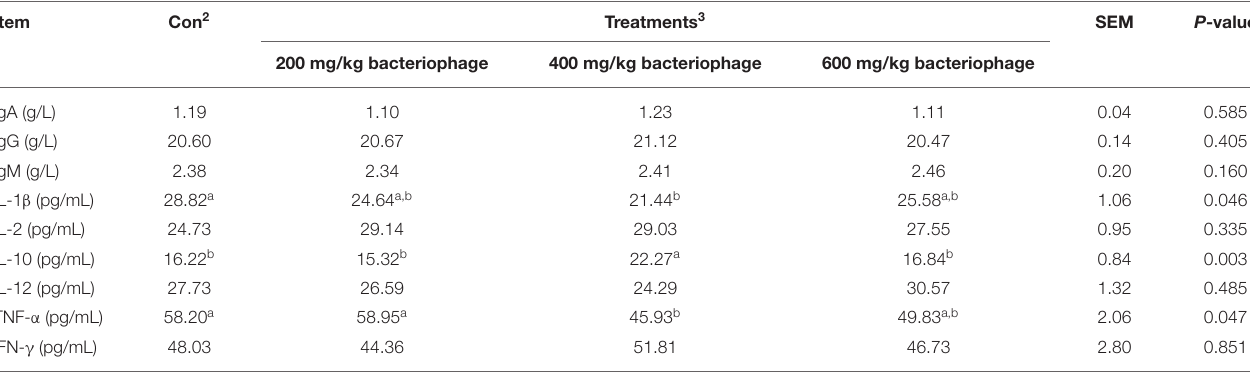
TABLE 4 | Effect of dietary bacteriophage supplementation on the concentration of immunoglobulins and cytokines in the serum of weaned piglets fed antibiotic-free diet ( n = 5) 1 . Item